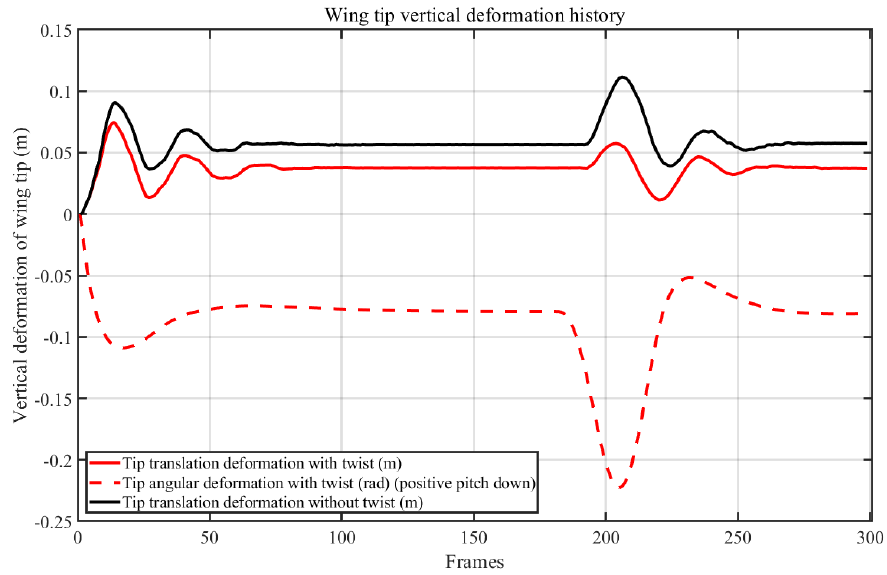
Figure A2. Prediction of the deformation of an aircraft wing tip with and without